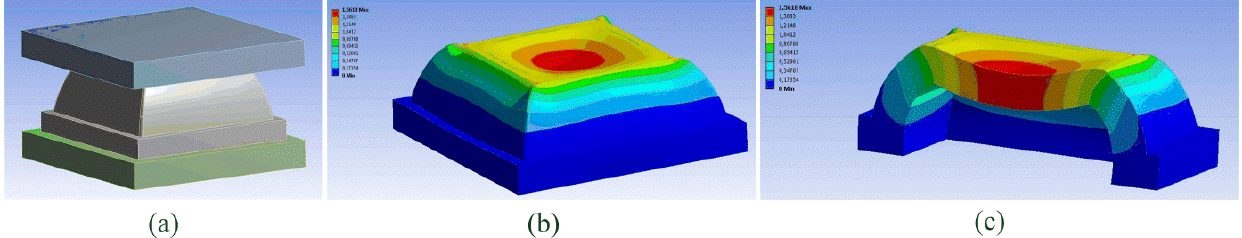
Figure 7. 3D FE simulations of PSP2.1: ( a ) simulation environment: in blue the rigid indenter, in grey the silicone structure, in green the PCB; ( b ) map of the total deformation, ( c ) cross-section of the pyramidal frustum showing the sinking